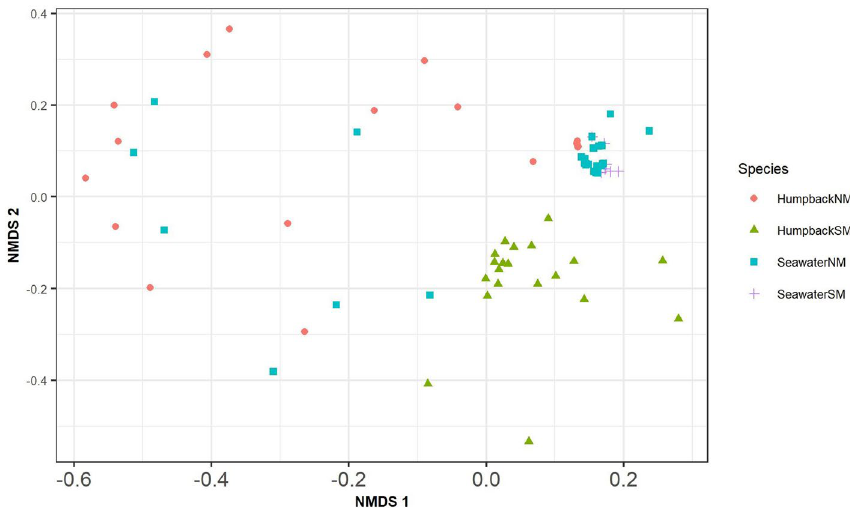
Figure 2. nMDS of microbiota, based on Bray–Curtis dissimilarity and unrarefied data, found in the blow of 20 humpback whale (HumpbackNM) and 26 seawater (SeawaterNM) samples at the beginning of the whales’ fasting and of 20 humpback whale (HumpbackSM) and 7 seawater (SeawaterSM) samples at a later state after deleting putative technical contaminant zOTUs from the dataset. The nMDS plot shows group-specific clustering of HumpbackSM, SeawaterSM and SeawaterNM, whereas the HumpbackNM samples did not form a distinct cluster. An overlap between whale and seawater samples, especially in the case of HumpbackNM and HumpbackNM is observed.